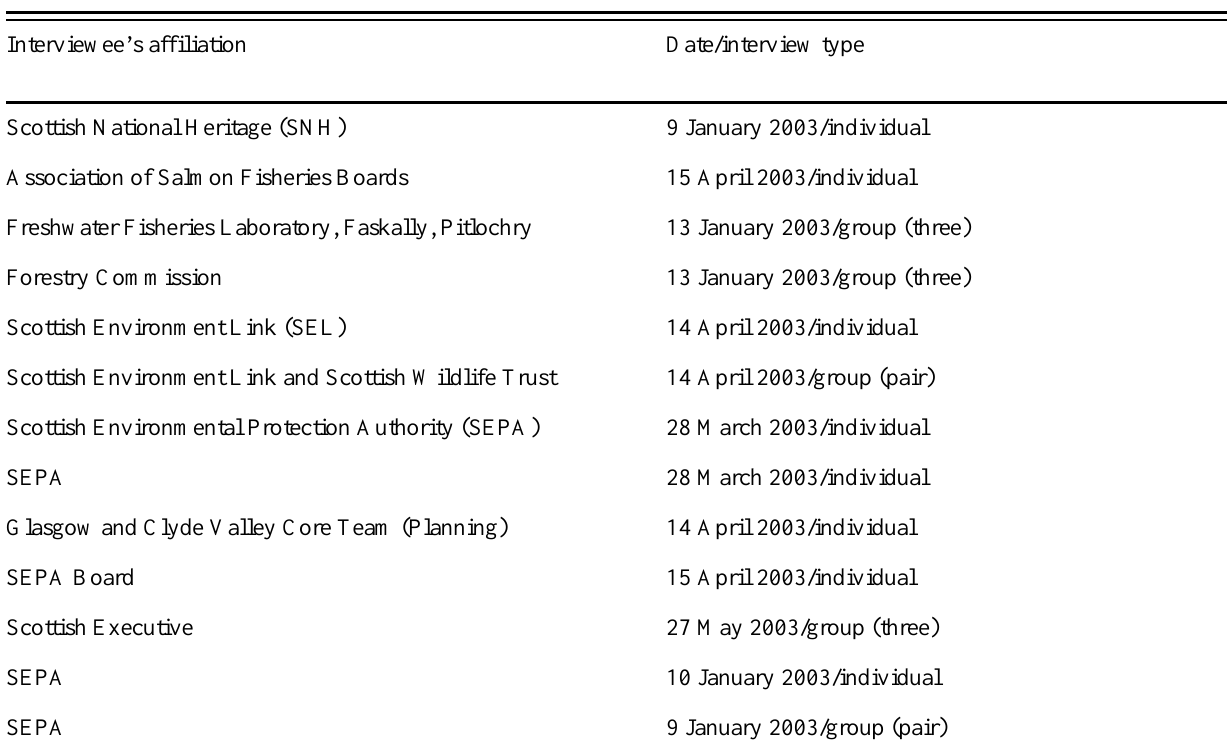
Table A1-1 . Details of semistructured interviews conducted for this